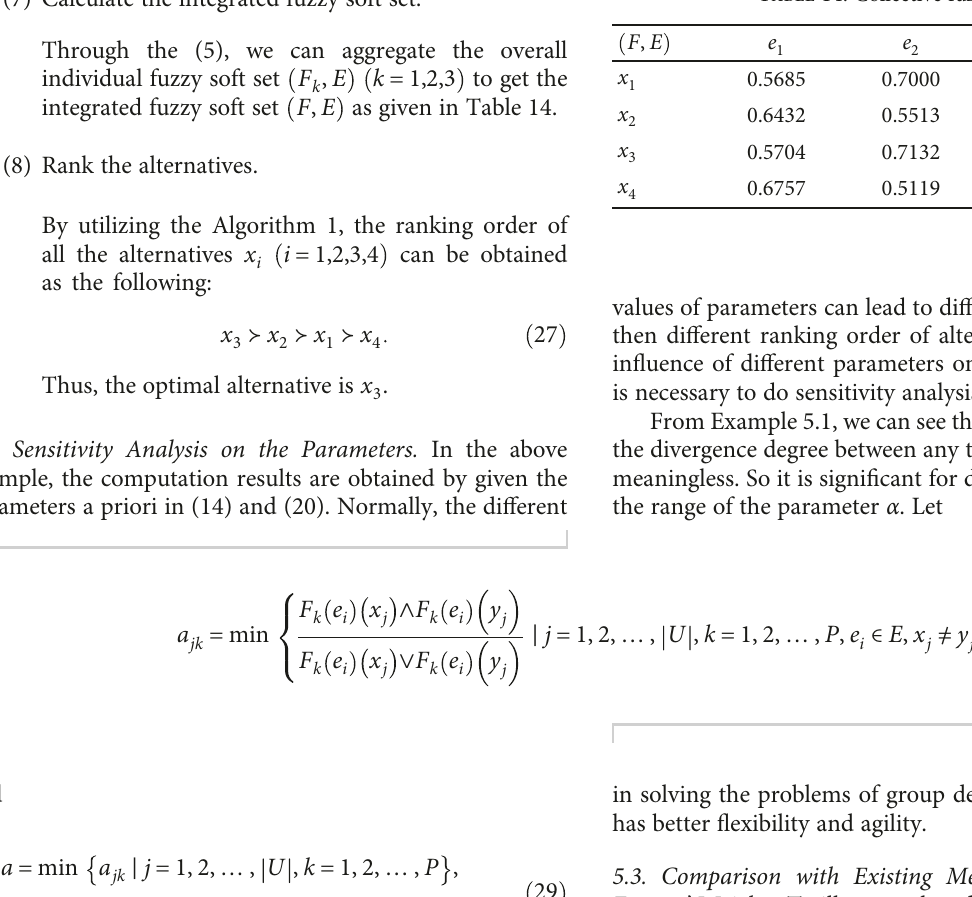
Table 14: Collective fuzzy soft